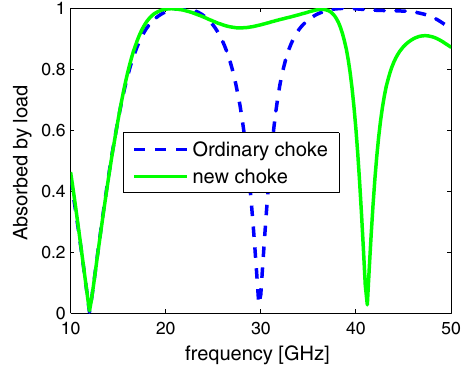
FIG. 9. New choke geometry.